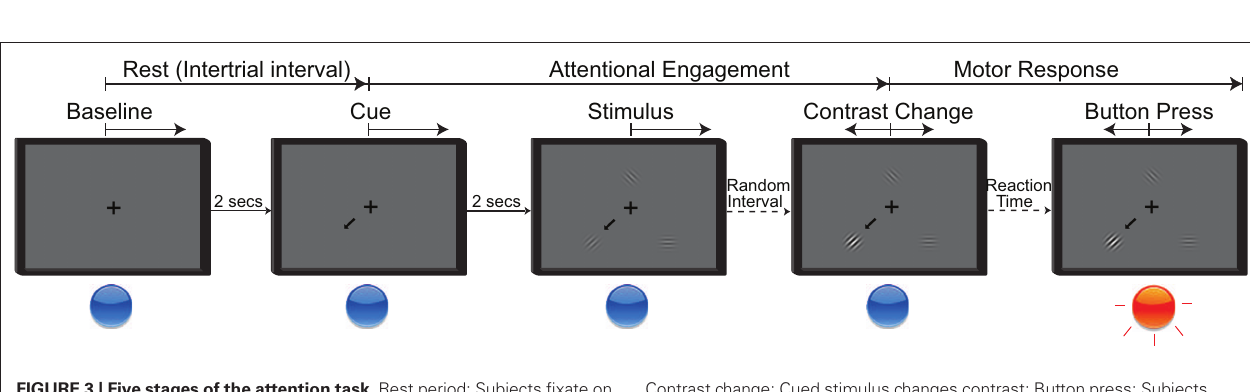
FIGure 2 | experimental setup. The subject was presented with visual cues and stimuli on a computer screen with built-in eye tracker, which verified ocular fixation on the central cross during data acquisition. The eye tracker, push